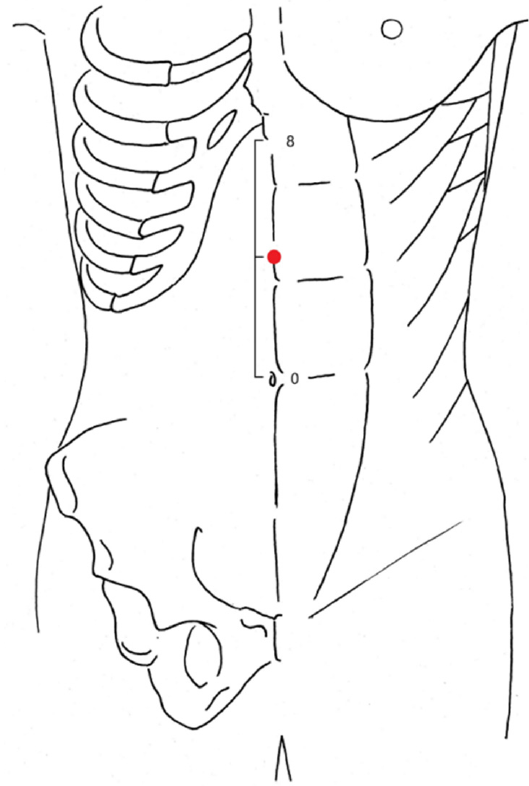
Figure 1. Zhongwan (CV12) (indicated as a red dot) is located on the anterior midline, 4 cun above the umbilicus. 1 cun is equivalent to 30.3 mm.